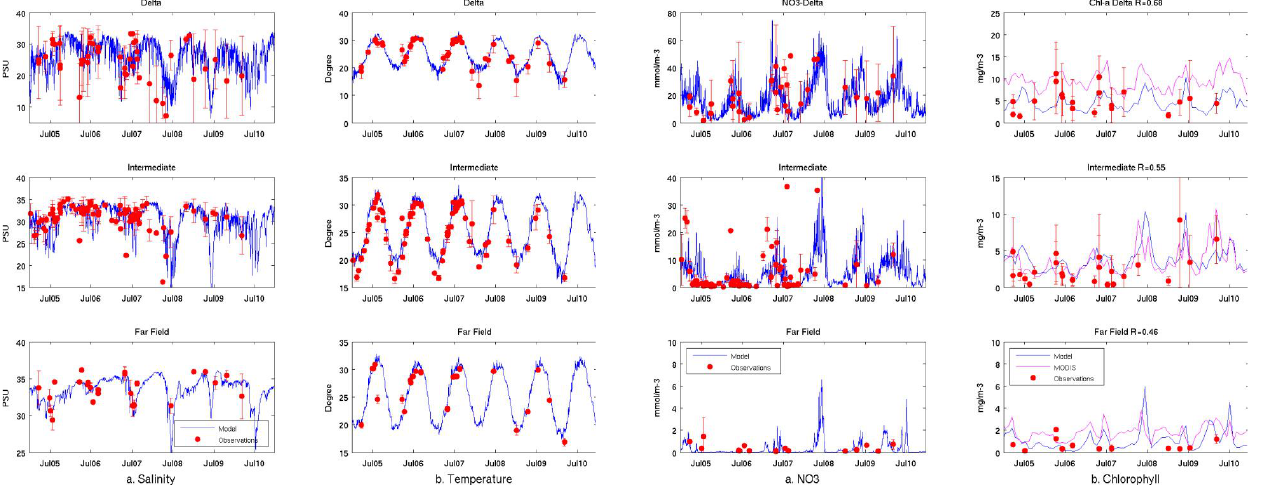
Fig. 7. Time series comparison between observed and simulated